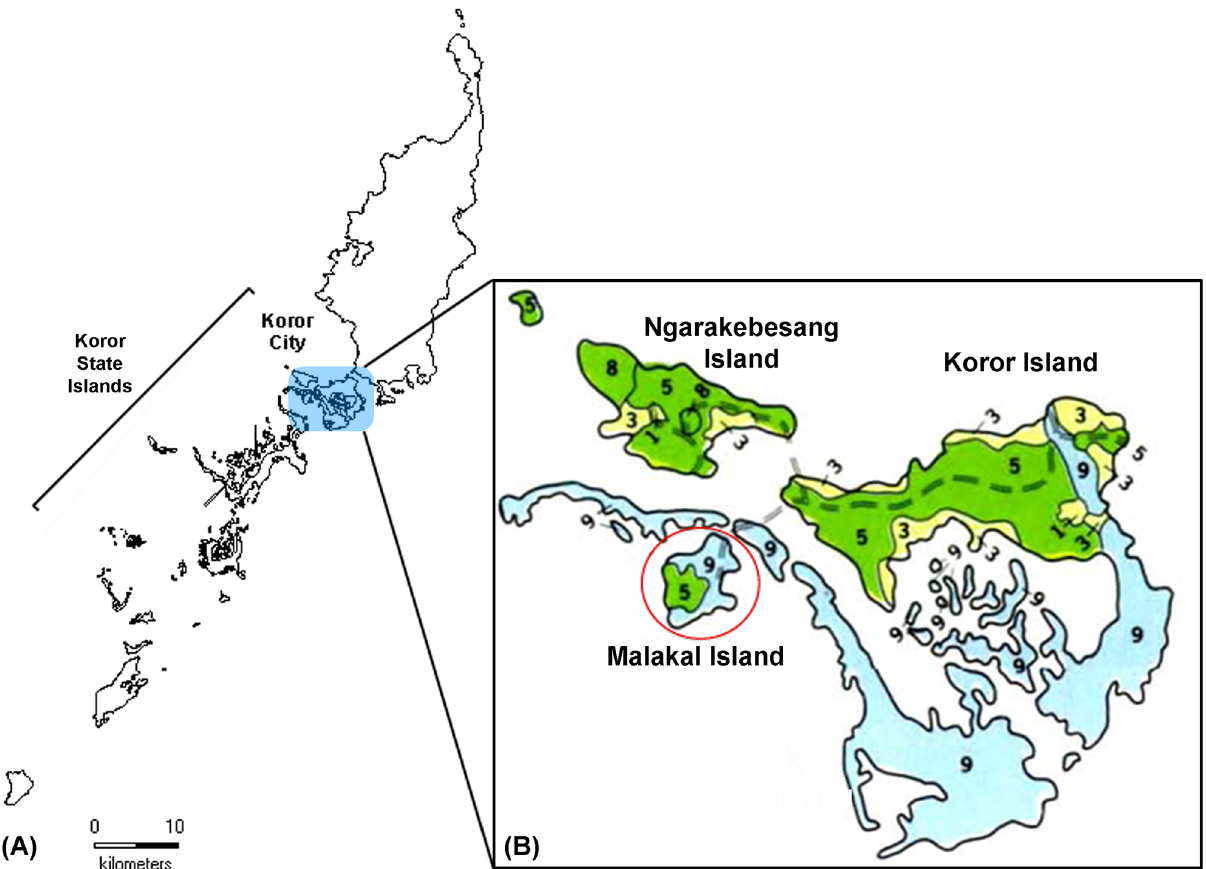
Fig 2. The Palau archipelago (A) is shown with the Koror State region in brackets and the Koror urban district highlighted in blue. Zoomed in view of the Koror urban district (B) is shown will soil types color-coded (map derived from USDA Soil Survey of Islands of Republic of Palau [28]). Limestone soils are shown in light blue, volcanic soils in green, and coastal and intertidal areas in yellow (numbers 1 – 9 indicate subcategories of these three soil types). Malakal Island is circled in red and the other two inhabited islands, Ngarakebesand Island and Koror Island are